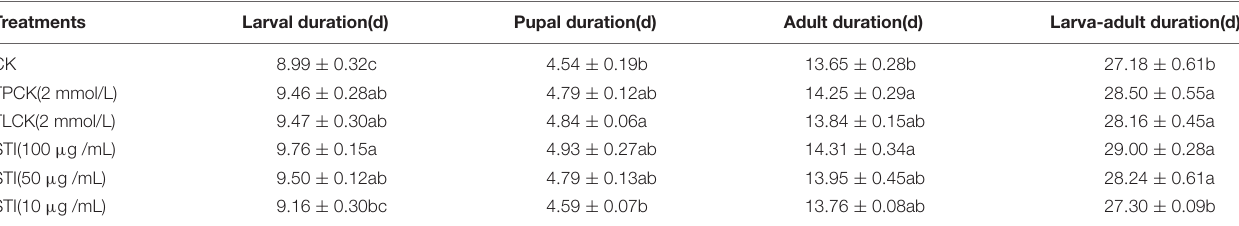
FIGURE 3 | Effects of ingesting different concentrations of the protease inhibitor, STI, on the midgut protease activity of Plutella xylostella larvae. (A) Total protease. (B) High-alkaline trypsin. (C) Low-alkaline trypsin. (D) Chymotrypsin. Columns represent means of three independent values and their SEM. Different lowercase letters indicate significant difference at P < 0.05 level using Tukey’s HSD test. TABLE 1 | Developmental duration of Plutella xylostella ingested different protease inhibitors. Treatments Larval duration(d) Pupal duration(d) Adult duration(d)